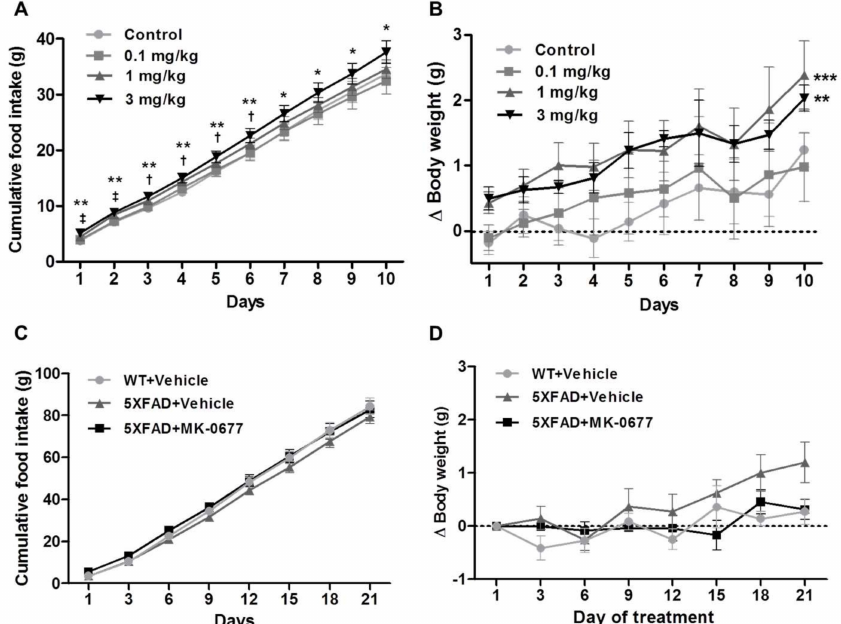
Figure 1. Cumulative food intake and change in body weight after the administration of MK-0677 in C57BL/6 mice and 5XFAD mice. MK-0677 was administered daily to C57BL/6 mice ( n = 5) at doses of 0.1, 1, and 3 mg/kg for 10 days and to 5XFAD mice at doses of 5 mg/kg for three weeks. The group injected with MK-0677 exhibited a significant increase in cumulative food intake compared with the control group. Compared with the control group, the significant difference indicators are as follows: 0.1 mg/kg group ( † p < 0.05), 1 mg/kg group ( ‡ p < 0.001), and 3 mg/kg group (* p < 0.05 and ** p < 0.01) ( A ). The body weight changes for 10 days were also significantly increased in the group receiving MK-0677 (** p < 0.01 and *** p < 0.001 indicate significant differences compared to control group) ( B ). MK-0677-treated 5XFAD mice ( n = 8) showed tendency to the increase of cumulative food intake induced compared with vehicle-treated 5XFAD mice ( n = 8) ( C ). The body weight changes among wild-type mice ( n = 8), vehicle- and, MK-0677-treated 5XFAD mice were not significantly different ( D ).